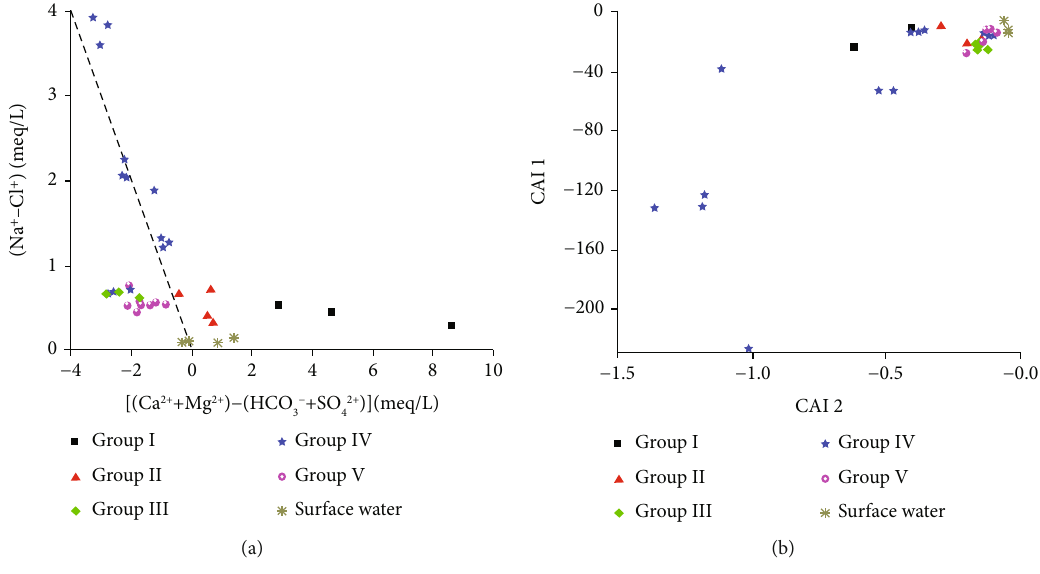
Figure 7: Cation reverse